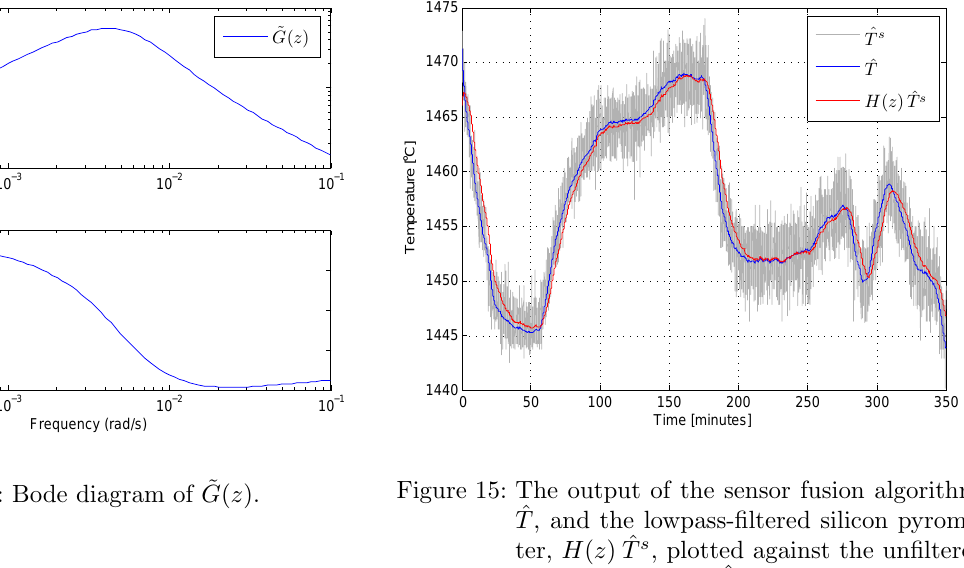
ˆ T , and the lowpass-filtered silicon pyrome- ter, H ( z ) ˆ T s , plotted against the unfiltered silicon pyrometer, ˆ T s